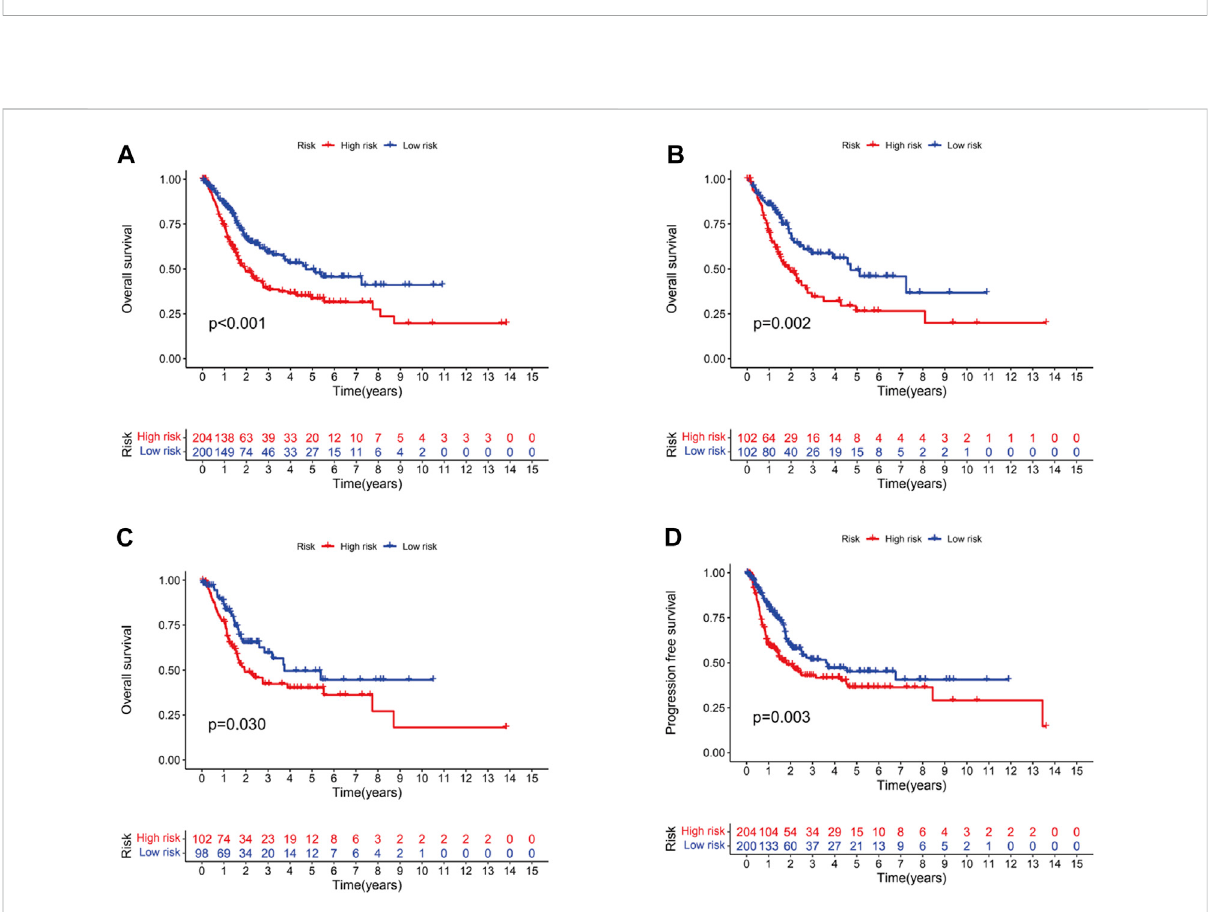
Kaplan-Meier survival analysis of BC patients. Overall survival of BC patients in all groups (A) , train groups (B) , testing groups (C) , respectively. (D) .PFS of BC patients in all